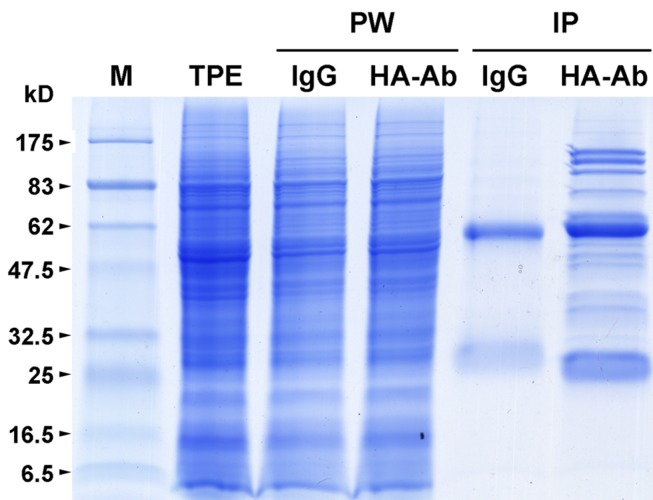
Immunoprecipitation of HA-tagged OseIF3f from panicle protein extracts. Total protein extracts (TPE) prepared from developing panicles of transgenic rice plants that overexpress the hemagglutinin (HA)-tagged rice eukaryotic translation initiation factor 3 subunit f (OseIF3f) were immunoprecipitated with mouse IgG coupled to Dynabeads Protein A (IgG) or a monoclonal anti-HA antibody coupled to Dynabeads Protein A (HA-Ab). TPE, unbound proteins washed away with the cold lysis buffer (PW) and Immunoprecipitates (IP) of HA-OseIF3f and IgG were separated by SDS-PAGE and visualized by Coomassie brilliant blue staining. Molecular weight standards (M) are marked on the left edge of the SDS-PAGE gels; kD, kiloDalton.